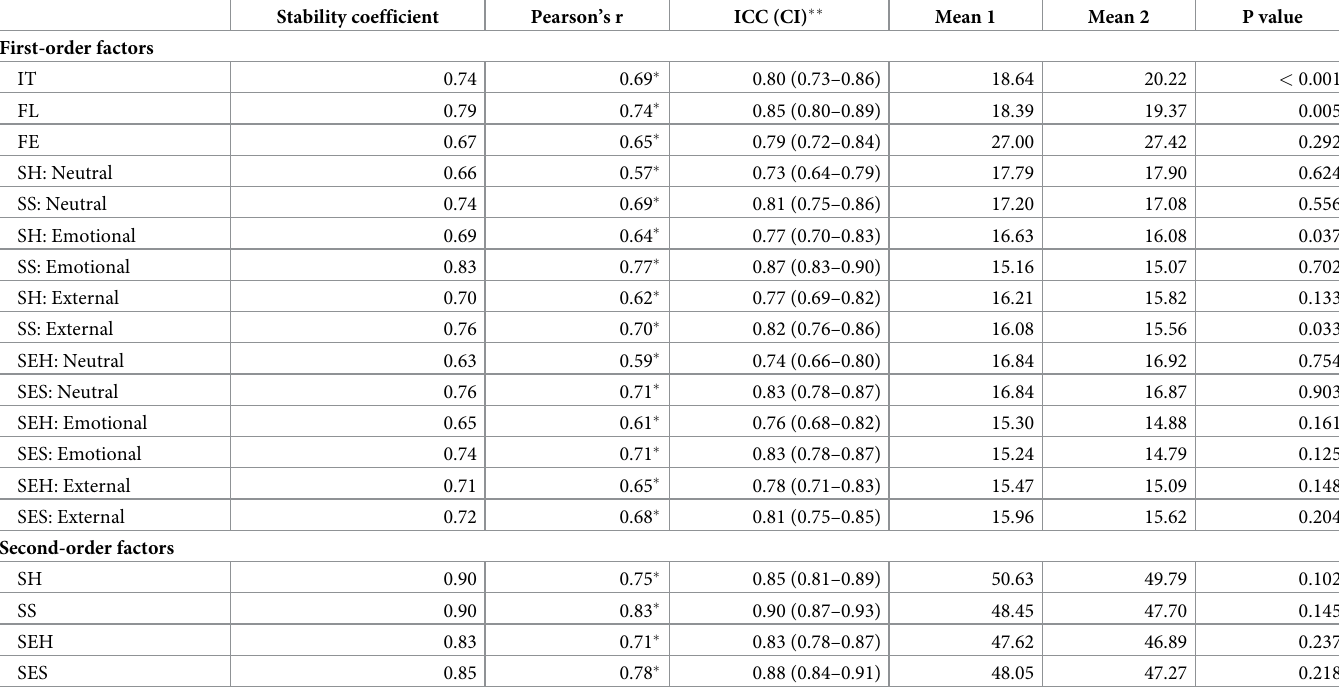
Table 4. Stability coefficients, Pearson correlation coefficients, intra-class correlation coefficients, and mean scores for the MIRES first- and second- order factors. Stability